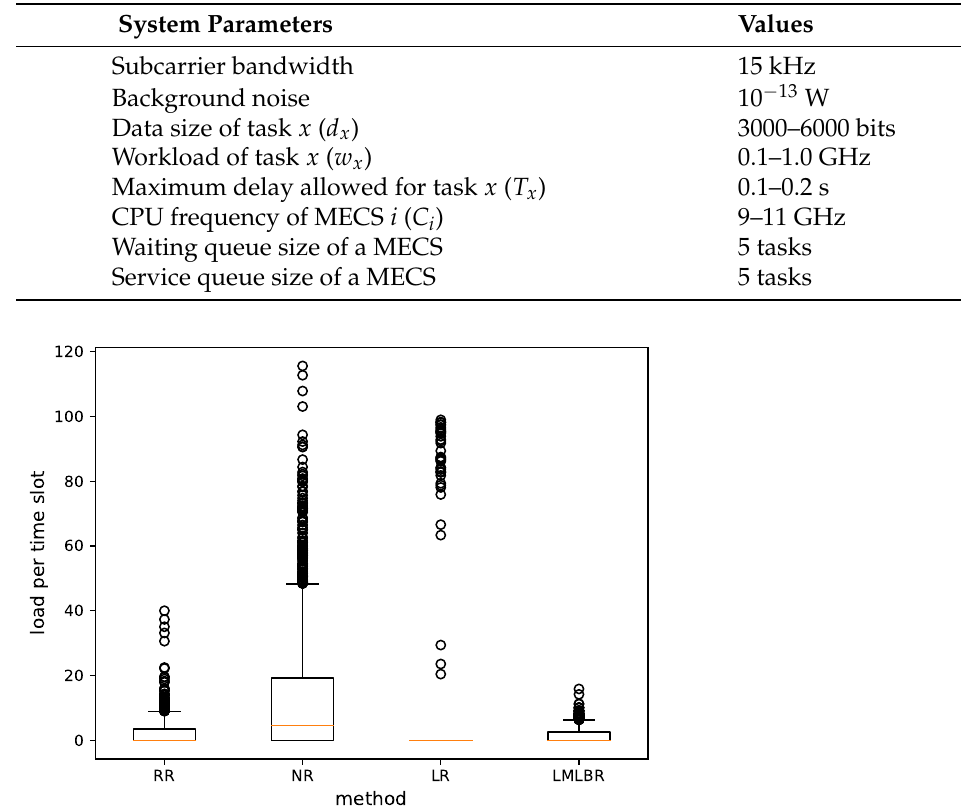
Table 2. Simulation parameters.